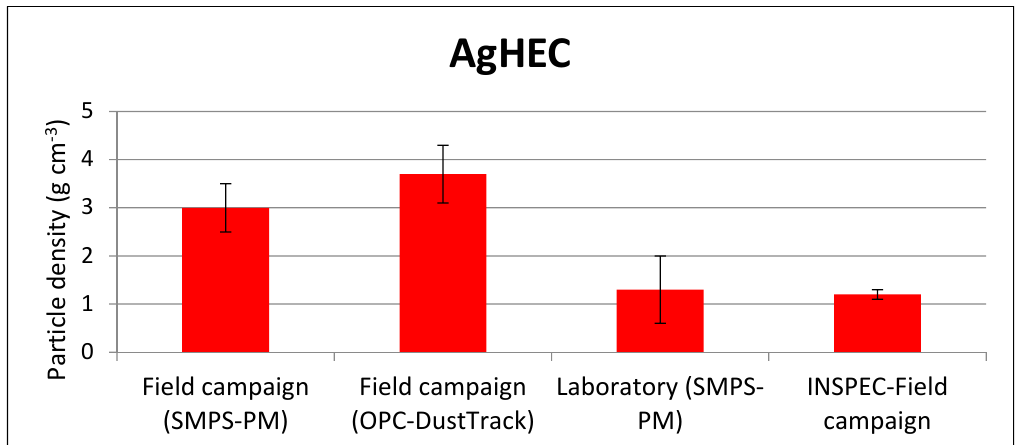
Figure 6. AgHEC atomized particle density values obtained with different techniques and atomization processes.